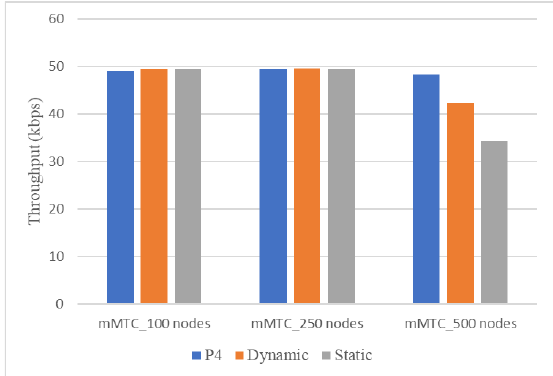
Figure 15. Average throughput per node in the mMTC slice.